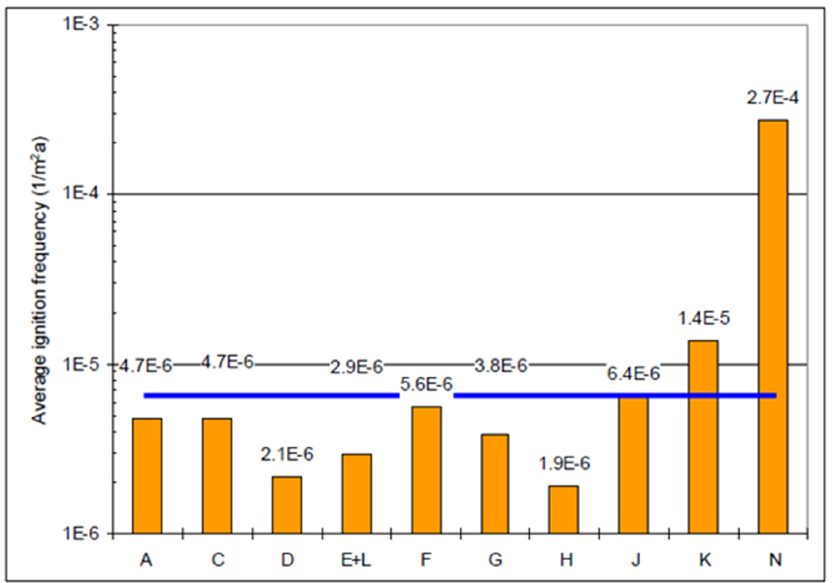
Figure 2. Average ignition frequencies of different building categories in Finland from 1996 to 1999 (extracted from Tillander and Keski-Rahkonen [5]).